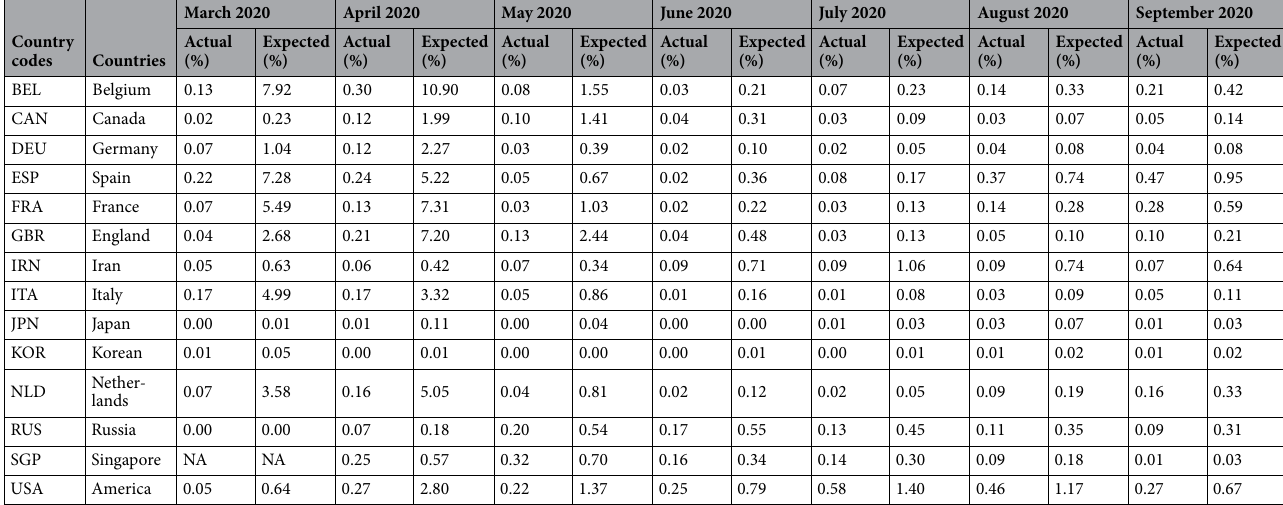
Table 1. Actual and expected prevalence rates in critical countries from March to September 2020.